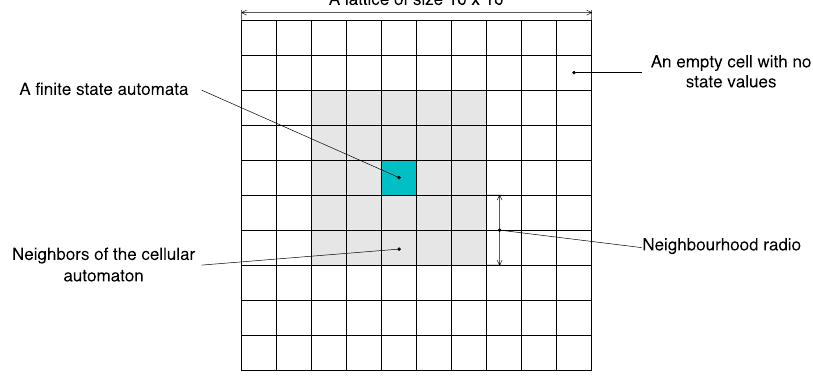
Figure 1. Cellular automata